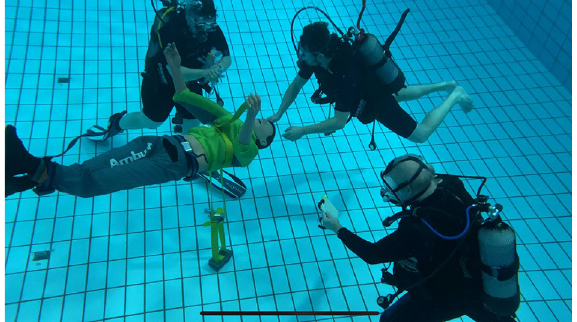
Figure 2. Underwater setting of the trial. The manikin is free floating approx. 1.5 m above the ground level and attached with straps to prevent significant dislocation. Clockwise description: Diver assisting with the devices (left); volunteer paramedic (middle); additional diver/diving instructor for time count and documentation